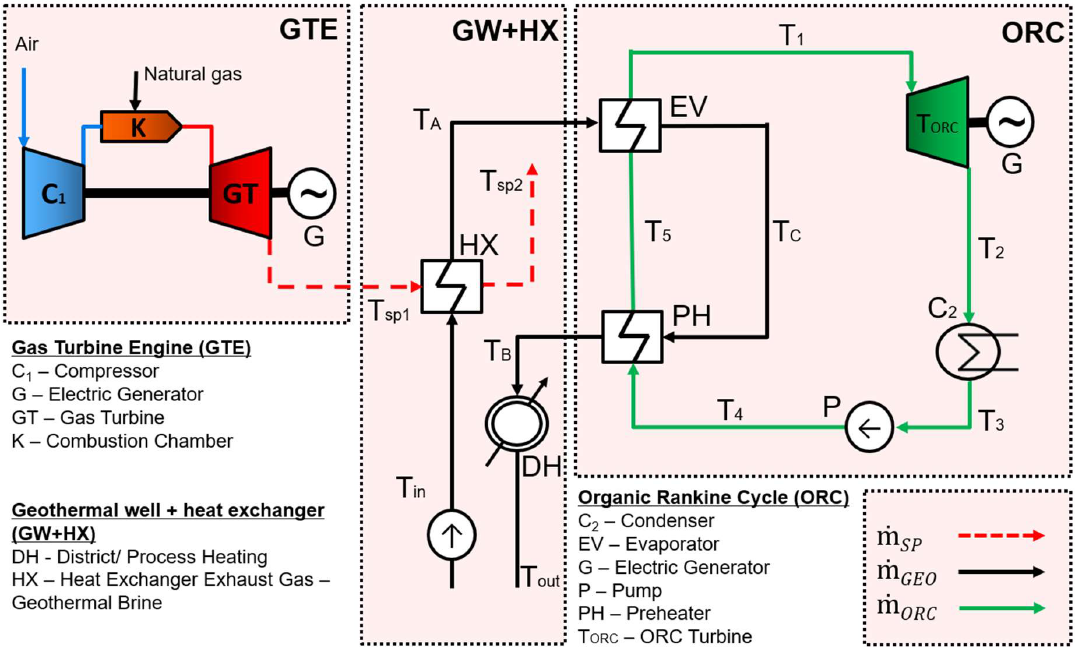
Figure 1. Simplified scheme of a modified ORC system supported by a gas turbine.